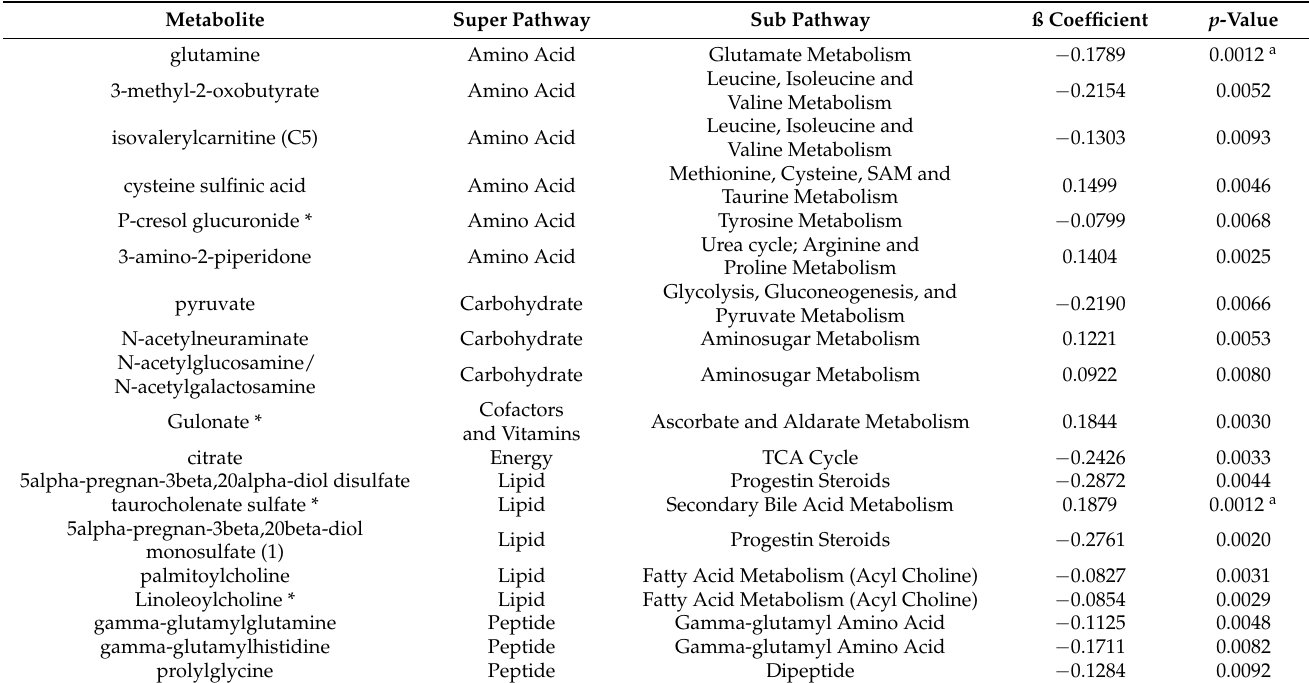
Table 5. Baseline metabolites associated with changes in area under the dark adaptation curve (AUDAC) at 3